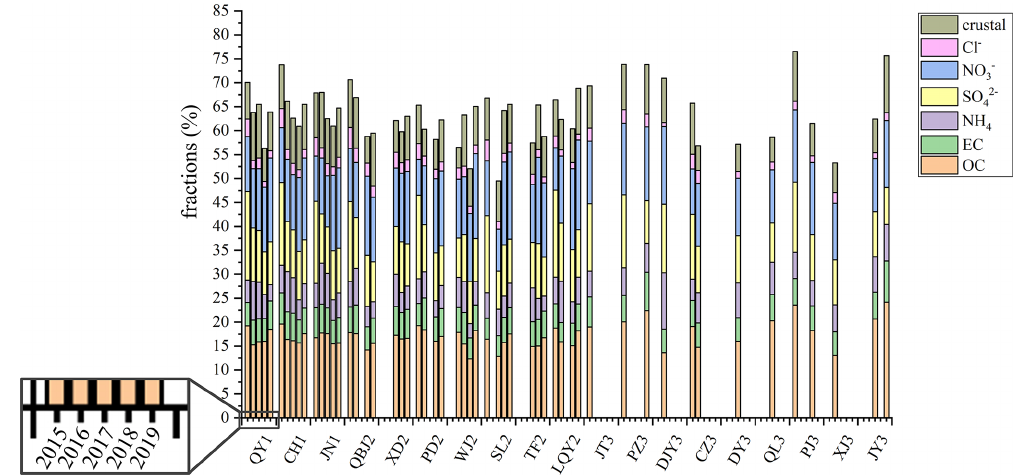
Figure 3. The spatiotemporal variations of the fractions of main chemical species in PM 2 . 5 at each site during winters in 2015 to 2019 (unit: